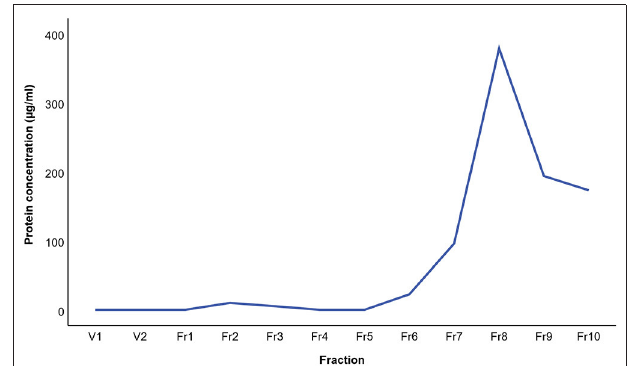
FIGURE 3 | Transmission electron microscopy image of extracellular vesicles isolated by size-exclusion chromatography from the bronchoalveolar lavage fluid of an asthmatic horse.